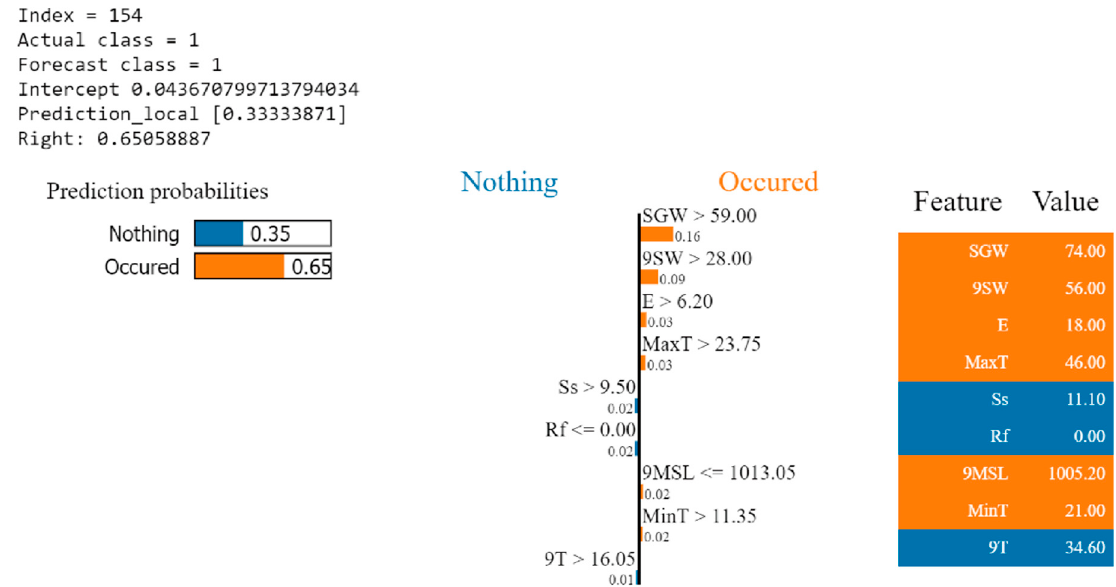
Figure 14. LIME explanation for a sample of No. 154.